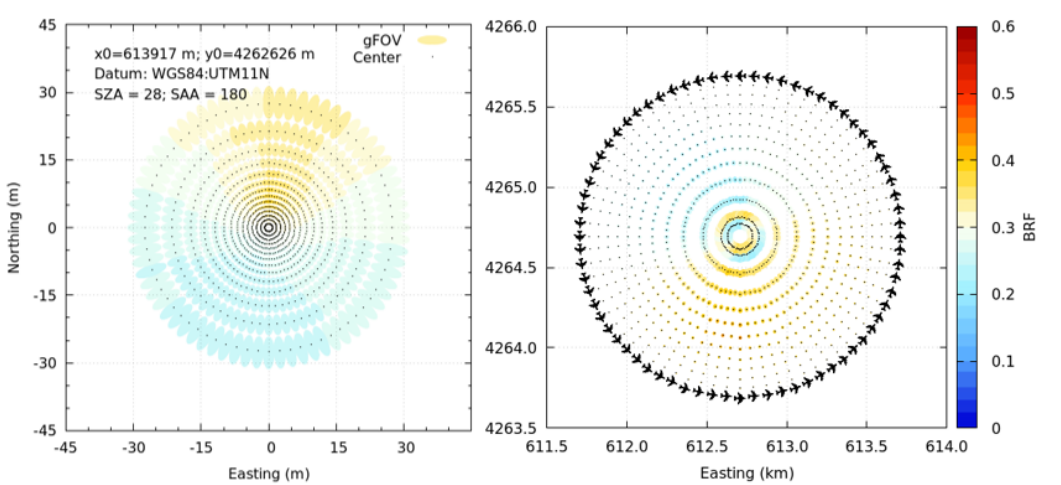
Figure 9. Polar representation of simulated PARABOLA ( left ) and CAR ( right ) BRF measurements with θ i = 28 ◦ ( φ i = 180 ◦ ). The ellipses mimic the actual surface footprints of a conical FOV of 5 ◦ and 1 ◦ in the different viewing directions up to a θ v = 60 ◦ . The radius of the CAR loops is set to 1 km in the simulations. The heights are 10 and 645 m for PARABOLA and CAR, respectively. The black dots represent the intersections of the field-of-view (FOV) axes with the surface (a focus of the